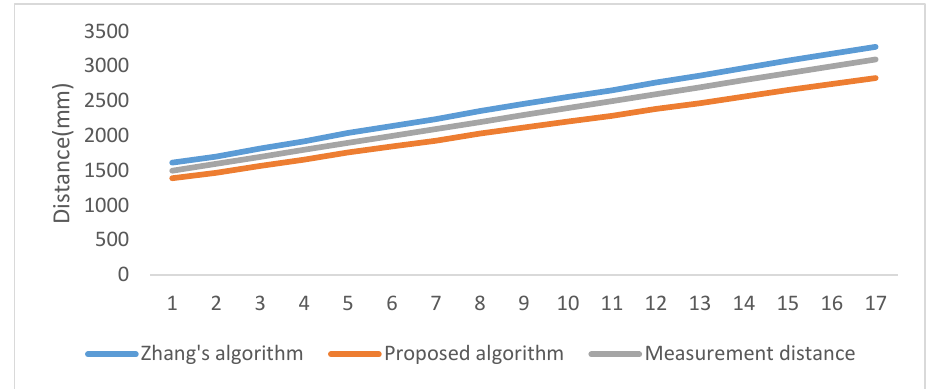
Figure 25. Comparison results with measurements using Zhang’s algorithm and proposed algorithms.